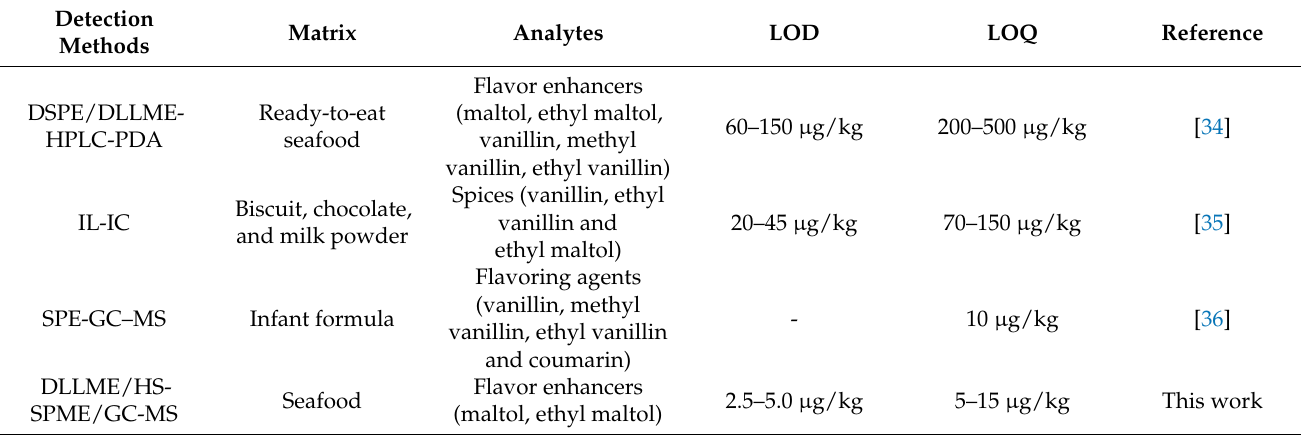
Table 2. Comparison of the present method with other methods a